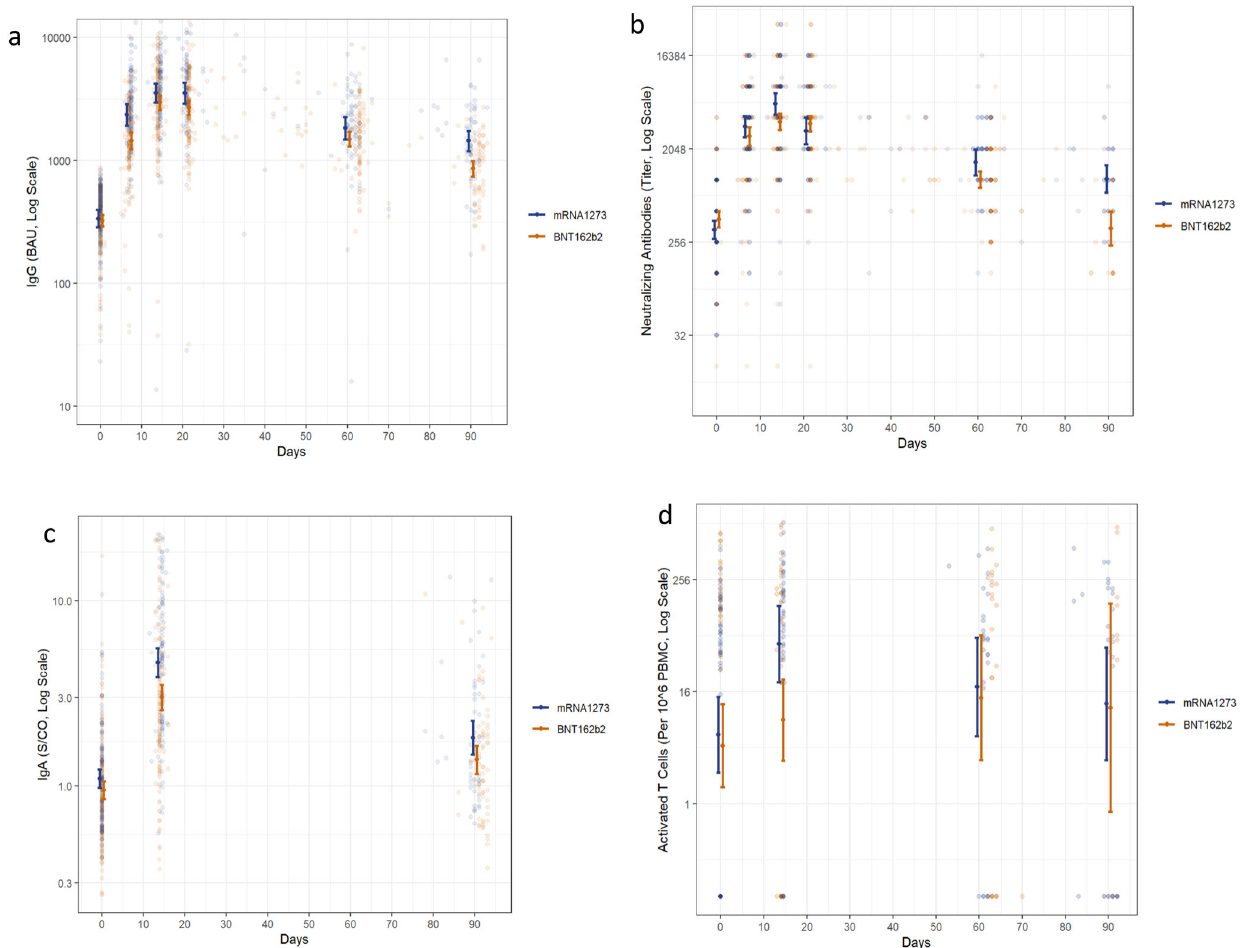
n =56, for BNT162b2: n =149, n =134, n =68,biologically independent samples, on days0,14,and90,respectively),and d numberof activatedTcells(formRNA1273: n =54, n =35, n =26, n =27, for BNT162b2: n =56, n =52, n =24, n =11, biologically independent samples, on days 0, 14, 60, and 90, respectively). In each fi gure, the raw values are presented on a log Y scale. Geometric mean titers and their 95% con fi dence intervals at each planned encounter are overlaid on the plot. Source data are provided as a Source Data fi